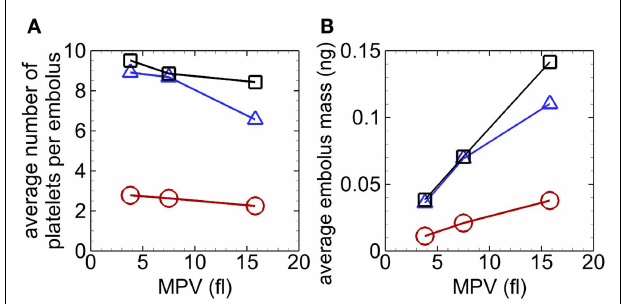
FIGURE 8 |Average number of platelets per embolus versus MPV (A) and average embolus mass versus MPV (B), with whole-lumen- seeded platelets ( triangles ), near-wall-seeded platelets ( squares ), and RBCs with platelets ( circles ), for the high tortuosity arteriole for Cases 4–12 .Values were averaged over the entire simulation time.